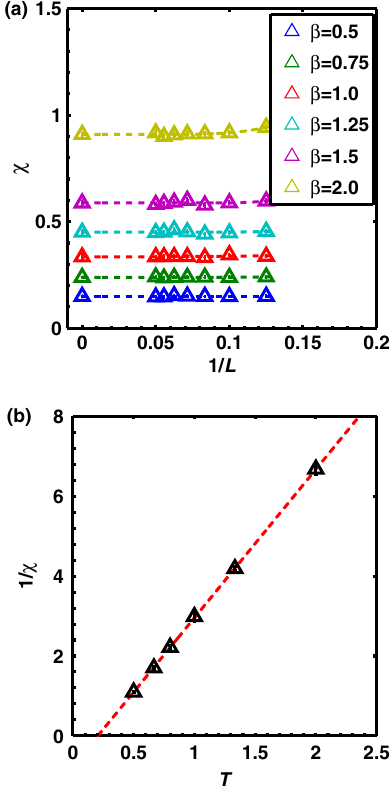
π ; π Þ =L 2 with the FIG. 16. The finite-size scaling of S orb ð parameter values J ⊥ ¼ J ∥ ¼ 2 , n ¼ 1 , and V ¼ 8 . The system FIG. 17. (a) The finite-size scaling of χ ð T; L Þ versus 1 =L in sizes range from L ¼ 10 to 60, and the values of inverse the off-critical region. Hund ’ s rule coupling is modified as J ⊥ ¼ 2 J ∥ ¼ 4 . (b) The CW behavior of the extrapolated temperature β are presented in the legend. The orbital ordering χ − 1 ð T Þ . The interception on the temperature axis yields occurs at β between 7.2 and 7.6, which corresponds to T T 0 =t ∥ ¼ 0 . 20 (cid:2) 0 . 01 =t ∥ ≈ 0 . 132 – 0 . 139 . orb